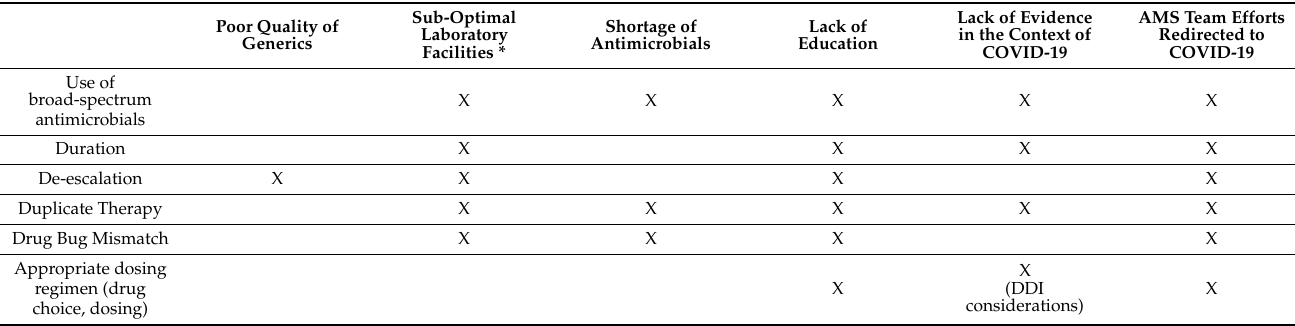
Table 1. Main AMS interventions: possible obstacles. We list the most common AMS interventions used by Antimicrobial Stewardship Programs and the potential obstacles and limitations due to the COVID-19 pandemic and some related to regional